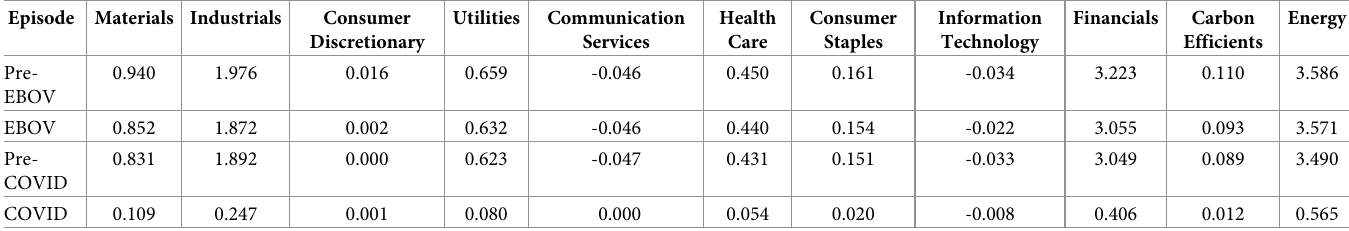
Table 11. Effectiveness of diversifying IEMV with each sectoral